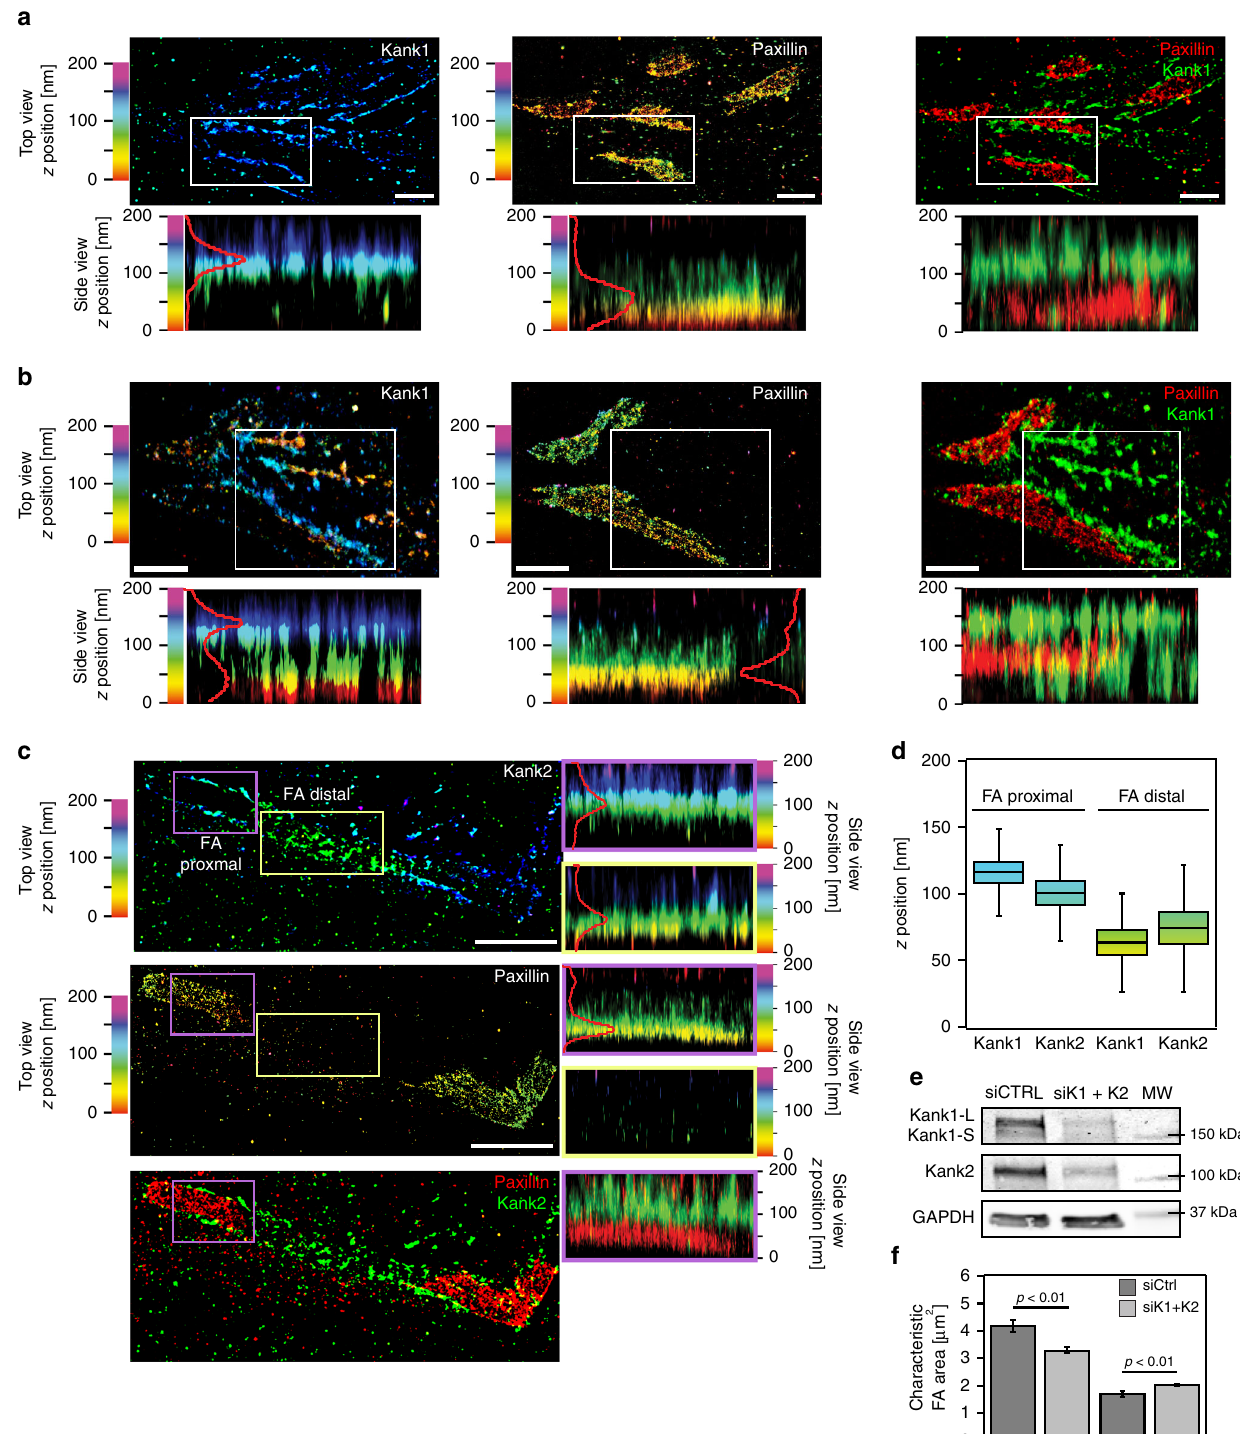
Cell culture gene silencing and transient transfection . The human-induced pluripotent stem cell (hPSC) lines HEL24.3 and HEL 11.4 were a kind gift from Timo Otonkoski (University of Helsinki, Finland). Cell lines were created using Sendai viruses 36,37 . Cells were grown in feeder-free conditions on Matrigel (MG) (Corning, 354277) or 5 μ g/ml VTN (Life Technologies, A14700) in Essential 8 (E8) Basal medium (Life Technologies, A15169-01) supplemented with E8 supplement